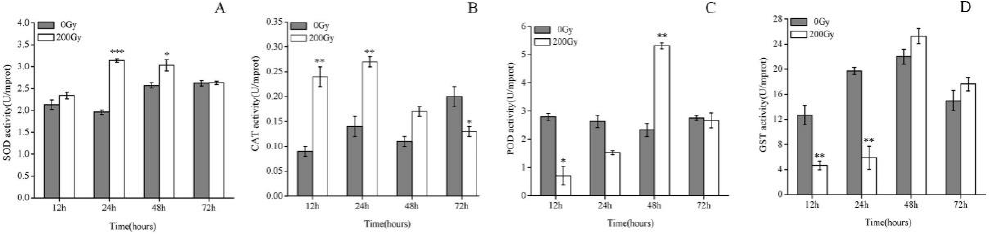
Figure 1. Effects of 60 Co- γ irradiation on activity of ( A ) SOD, ( B ) CAT, ( C ) POD, ( D ) GST in the pupal stage of P. xylostella at different time points post irradiation. Values are the mean ± SD ( n = 3). Asterisk designates statistically significant difference between control and irradiated pupae (*** p < 0.001; ** p < 0.01; * p < 0.05).